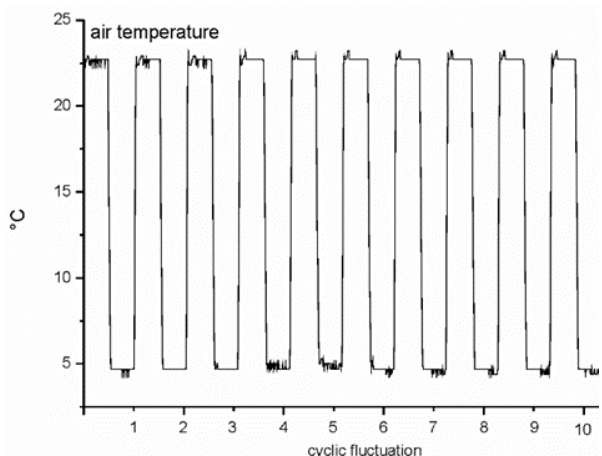
Figure 2. Cyclic stem radius variation (24 h) of F. sylvatica , C. sativa and P. sylvestris logs, and cyclic fluctuations (24 h) of air temperature in cooling test.